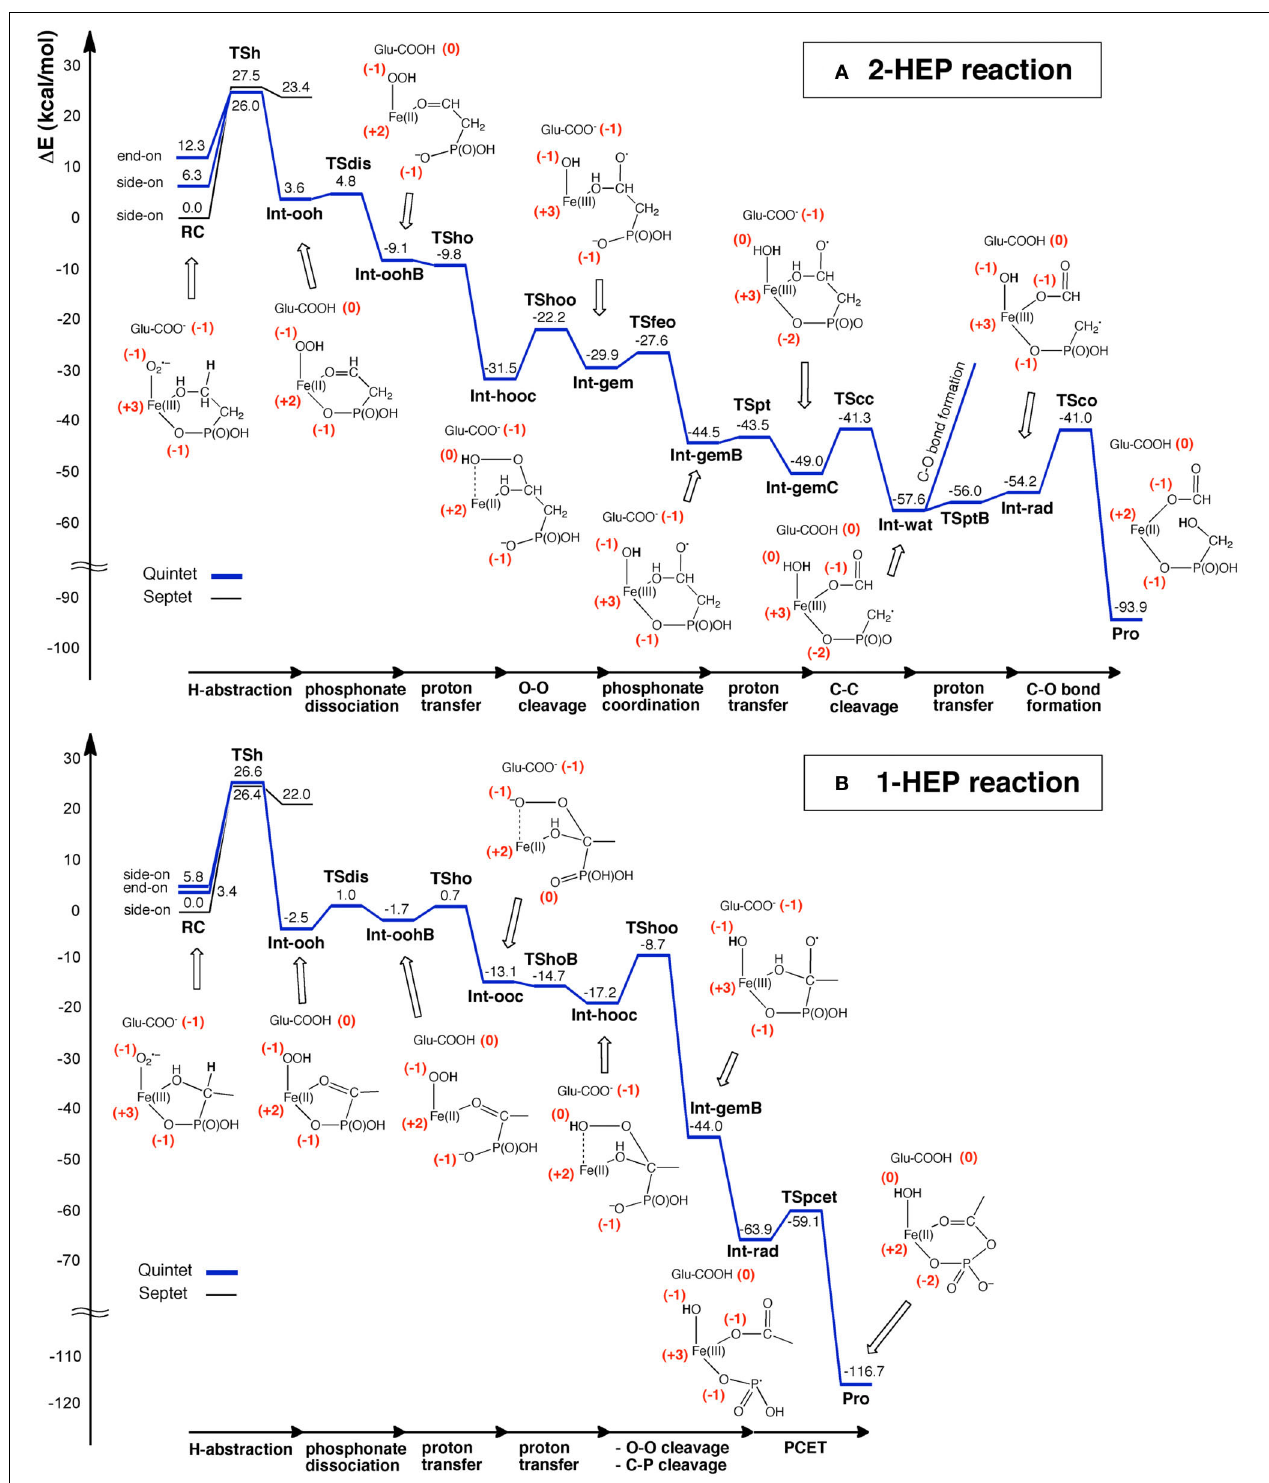
FIGURE 13 | Energy profiles for the reactions of (A) 2-HEP and (B) 1-HEP, determined by ONIOM(DFT:MM) calculations. Reprinted from Hirao and Morokuma (2011b) with permission from the American Chemical Society.